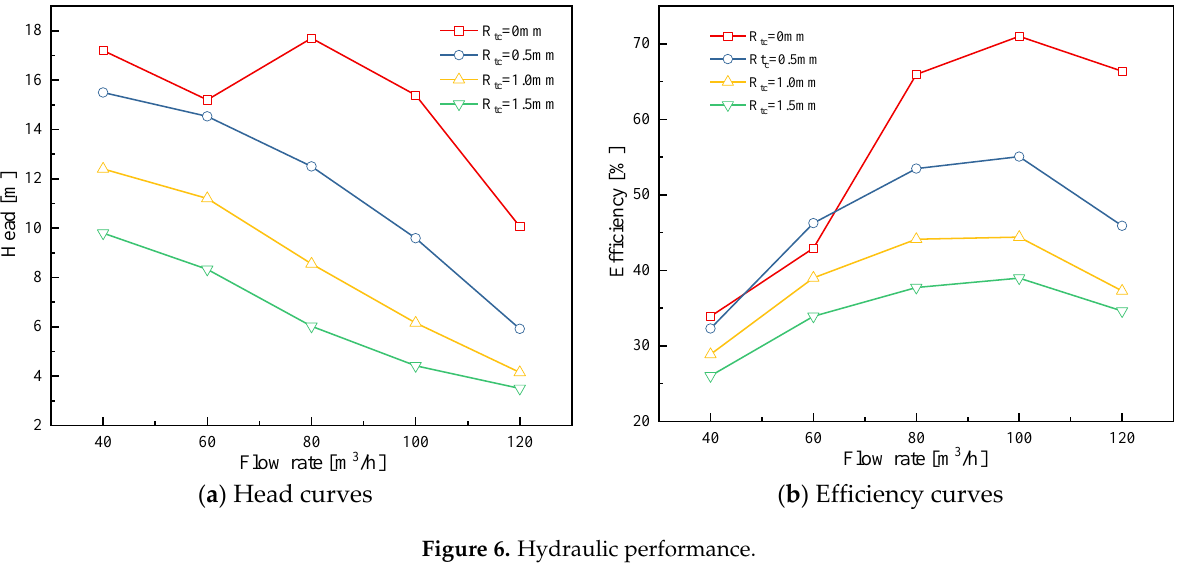
Figure 6. Hydraulic performance.